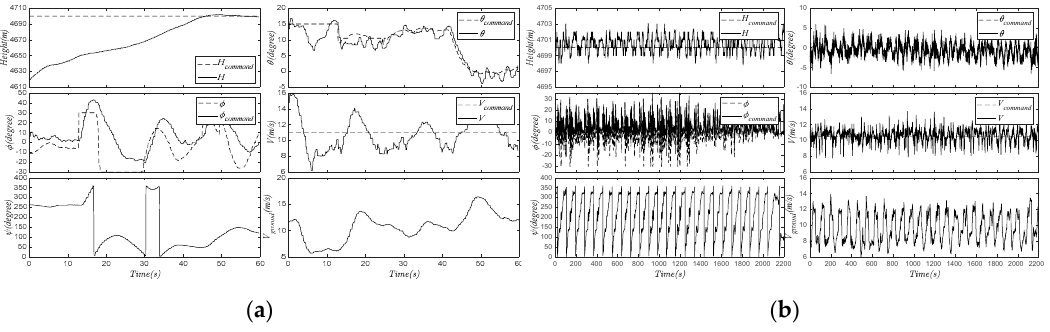
Figure 17. Flight result of field experiment: ( a ) Climb phase, ( b ) cruise phase.